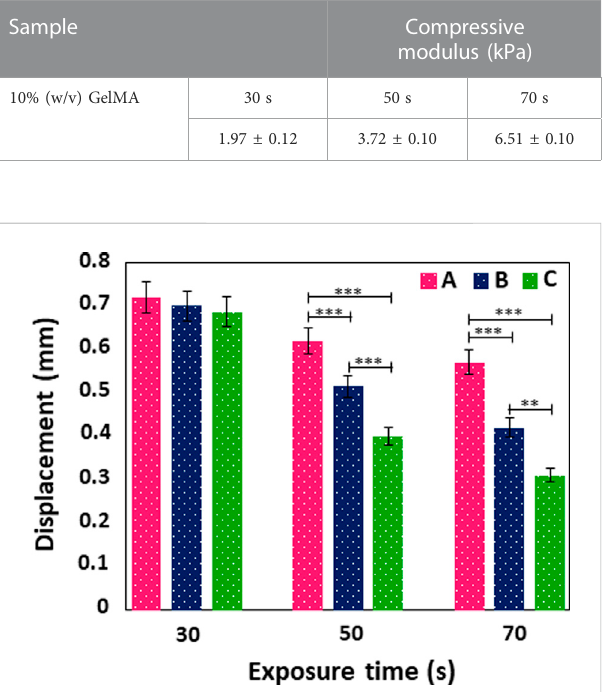
FIGURE 7 Displacement curve of GelMA MNs with different needle heights according to varying exposure times. Statistical difference is indicated with * p ≤ 0.05, ** p < 0.01, and *** p < 0.001. Error bars represent the standarddeviations(SDs)ofmeasurementsperformedonatleast three